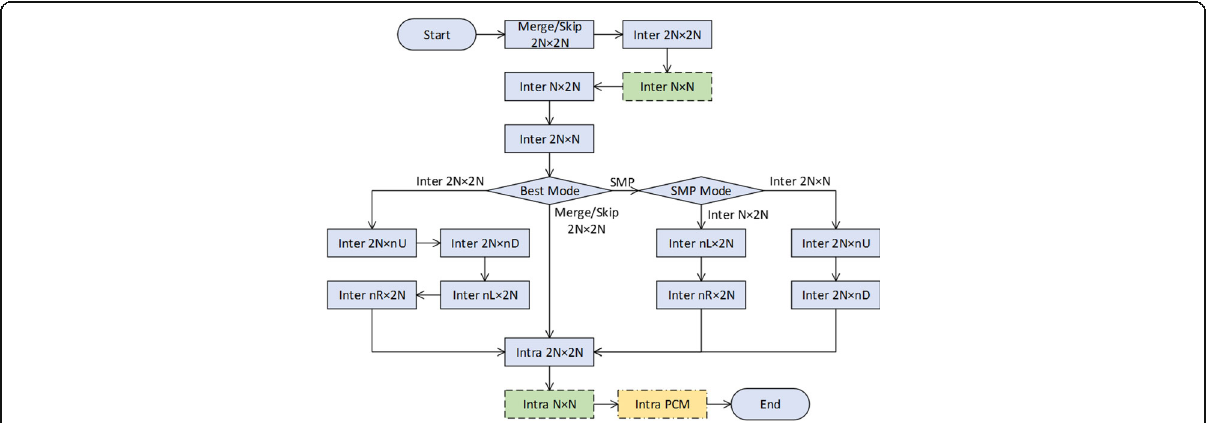
Fig. 3 The PU prediction procedure in HEVC reference software